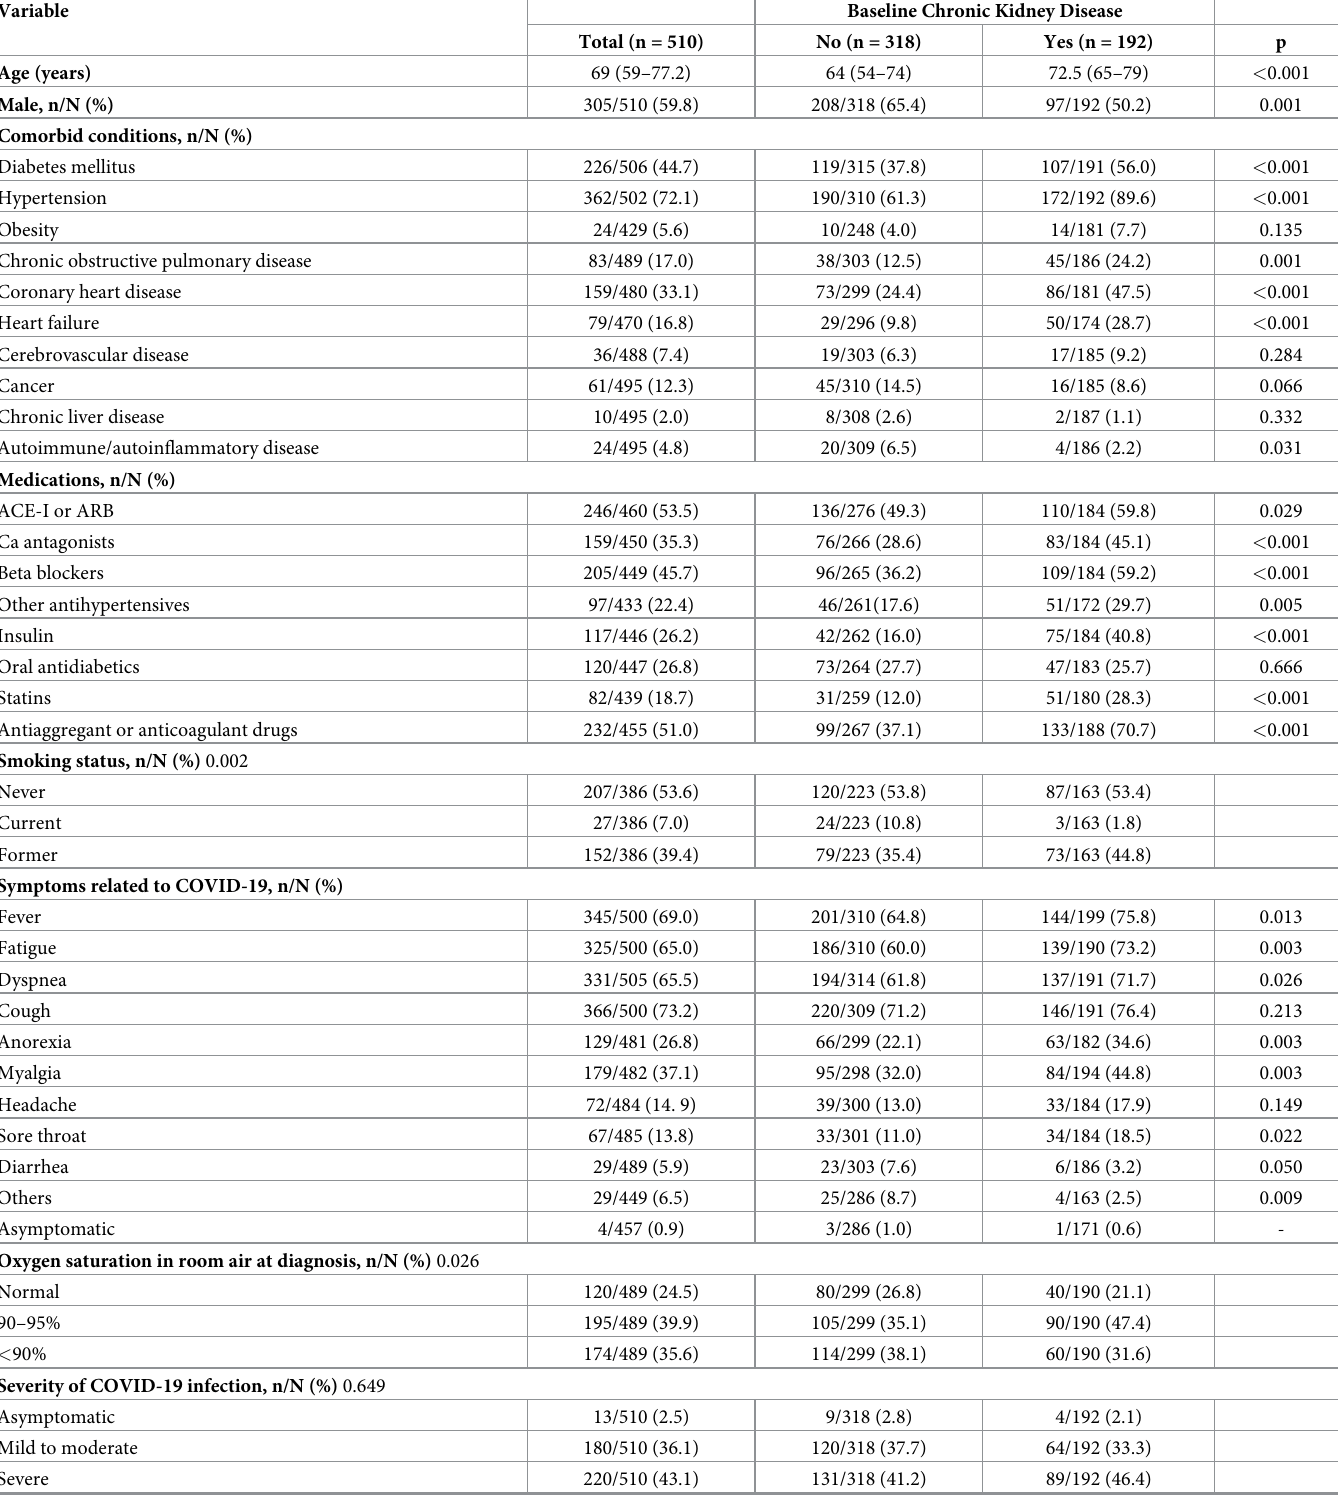
Table 2. Characteristics and outcomes of COVID-19 RT-PCR positive patients on the basis of baseline chronic kidney